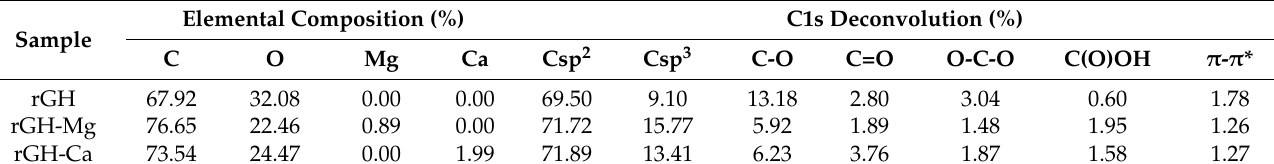
Table 3. Elemental composition, and C 1s binding energy obtained from X-ray photoelectron spectroscopy (XPS). Sample